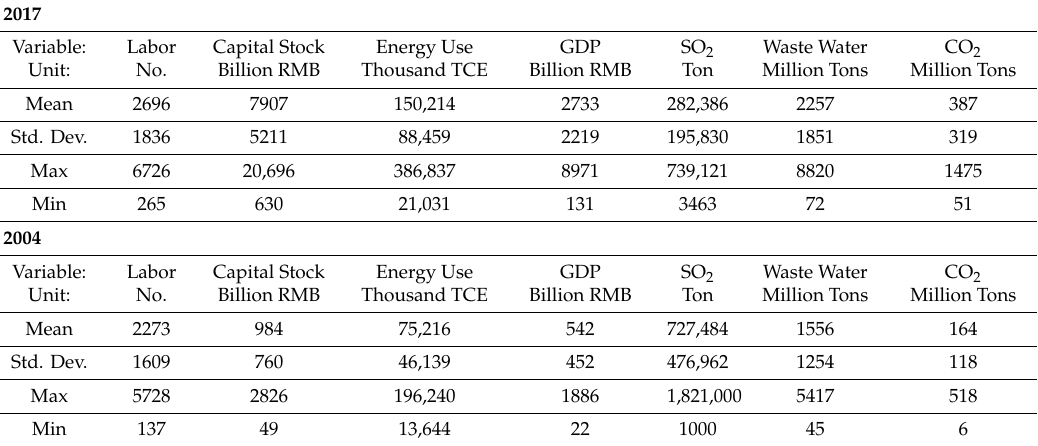
Table 1. Descriptive statistics for 2004 and